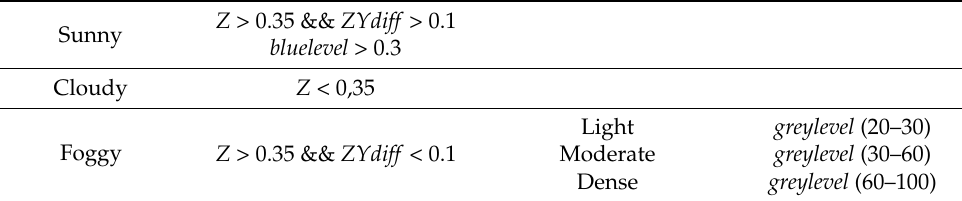
Table 3. The proposed rule-based method for fog detection and fog level estimation. This method anal-yses the RGB, HSV and XYZ colour